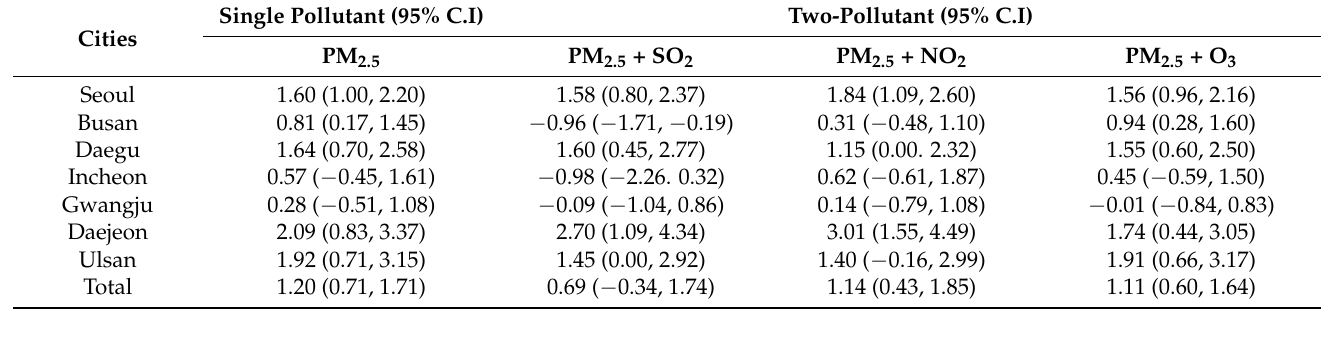
Table 3. Percentage change in PM 2.5 single pollutant model and two-pollutant model. The percentage change is calculated as the change per PM 2.5 10 µ g/m 3 increase. All models used the 7-day moving average exposure to PM 2.5 µ g/m 3 . The time-series model was adjusted for the same covariates (time, AT, day of weeks).